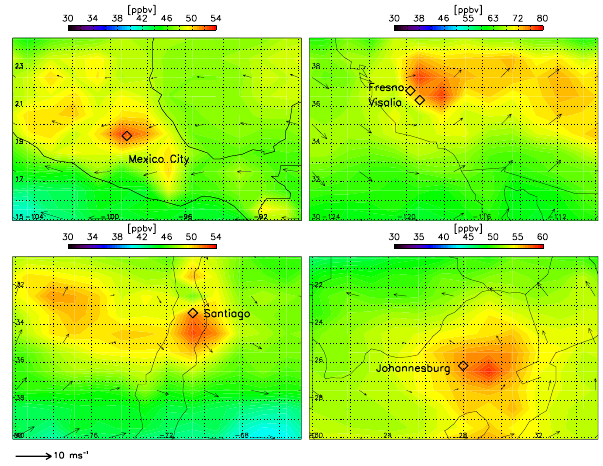
Fig. 7. Signatures of Mexico City (September), Fresno and Visalia (June), Santiago (February) and Johannesburg (January) in the cli- matological mean (2004–2008) tropospheric ozone VMR normal- ized for pressure variations at the surface and the tropopause. The NCEP reanalyses winds at 700hPa are averaged for the correspond- ing months between